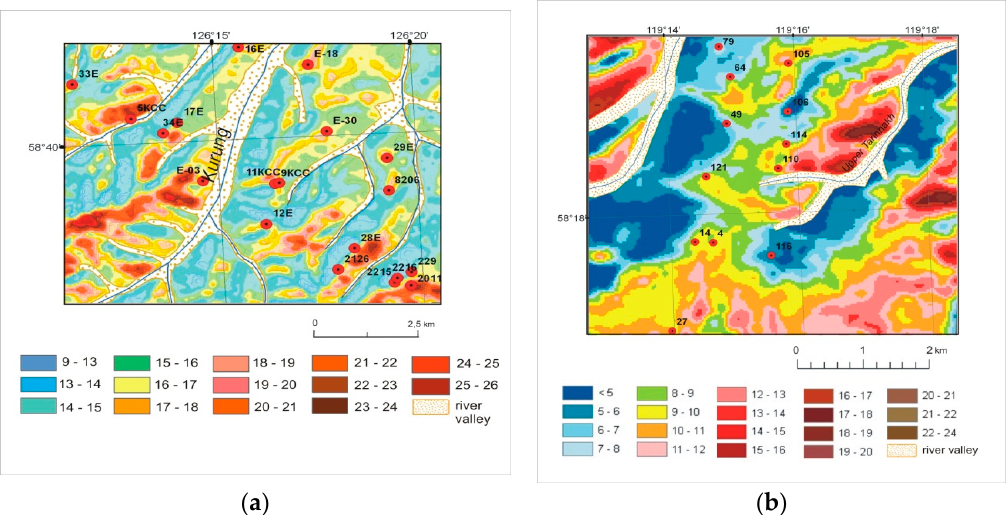
Figure 5. ( a ) LST, Elkon Massif, 21 August 2009. ( b ) LST, Olekma-Chara Upland (Tarinnakh field), 18 September 2009. Temperature in ◦ C. Numbered dots—numbers of geothermal